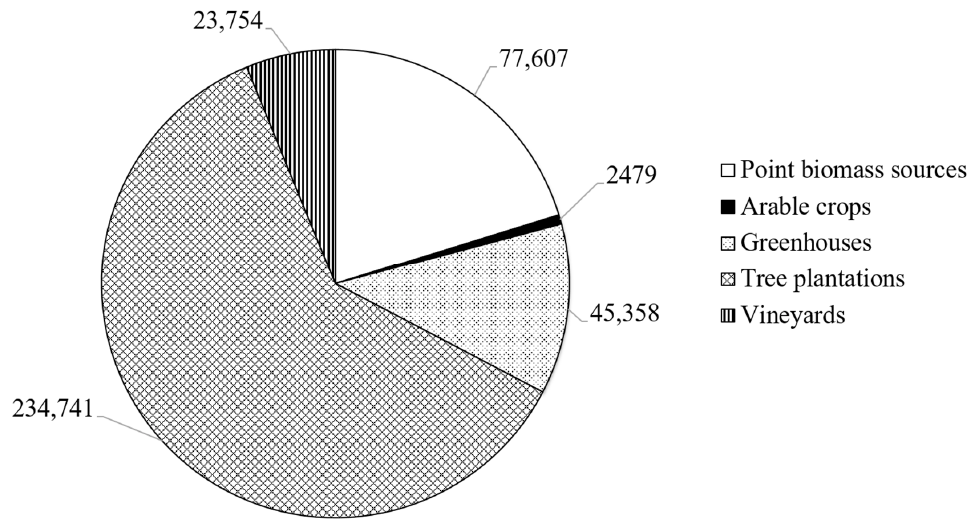
Figure 9. Total Biomass potential in the Region of Crete (in tonnes) by biomass source, 2010 [16].